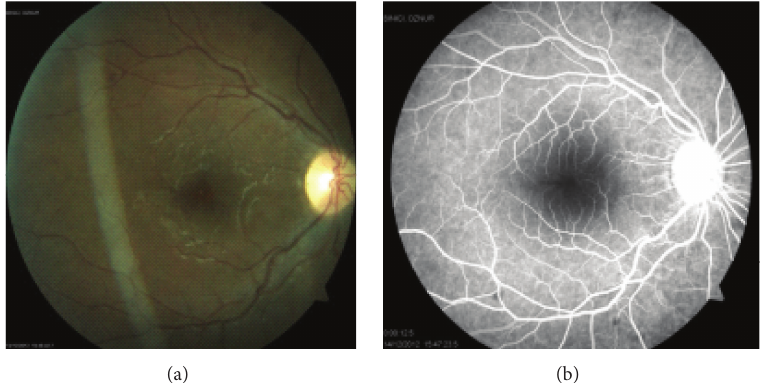
Figure 6: Fundus photograph (a) and FFA (b) of the right eye at the last